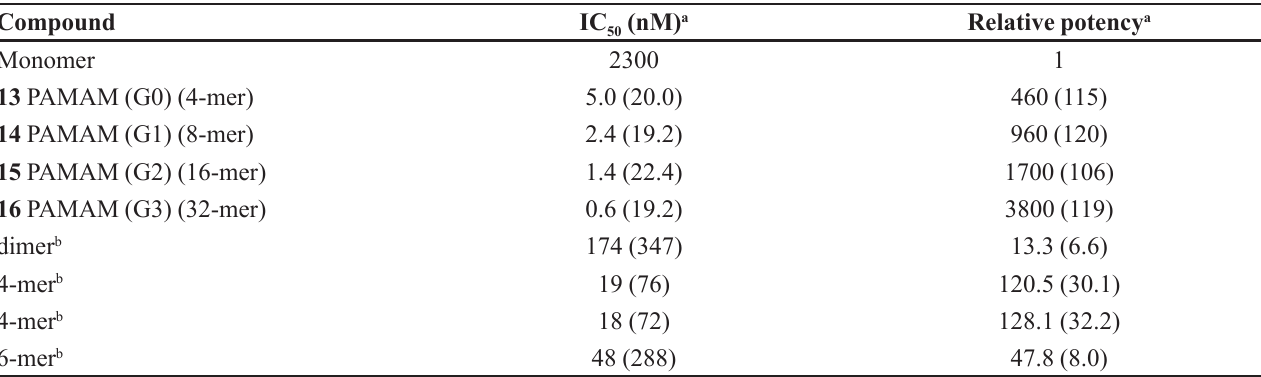
TABLE I - Relative inhibitory potencies (IC to coated